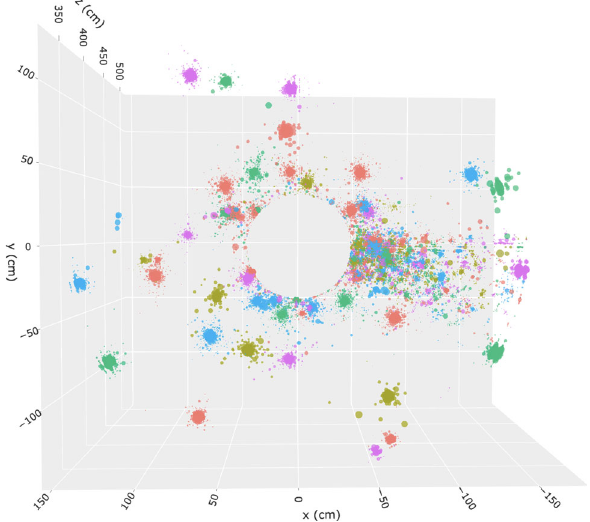
Fig. 6 Example of an event with pileup, part of the training set. No filter is applied to Type A simulations, but for pileup simulations, a filter, which selects particles (and their corresponding hits) between φ 0 and φ 0 + 30 ◦ , is applied. The high density of hits on the right side of the figure shows the slice in which pileup is